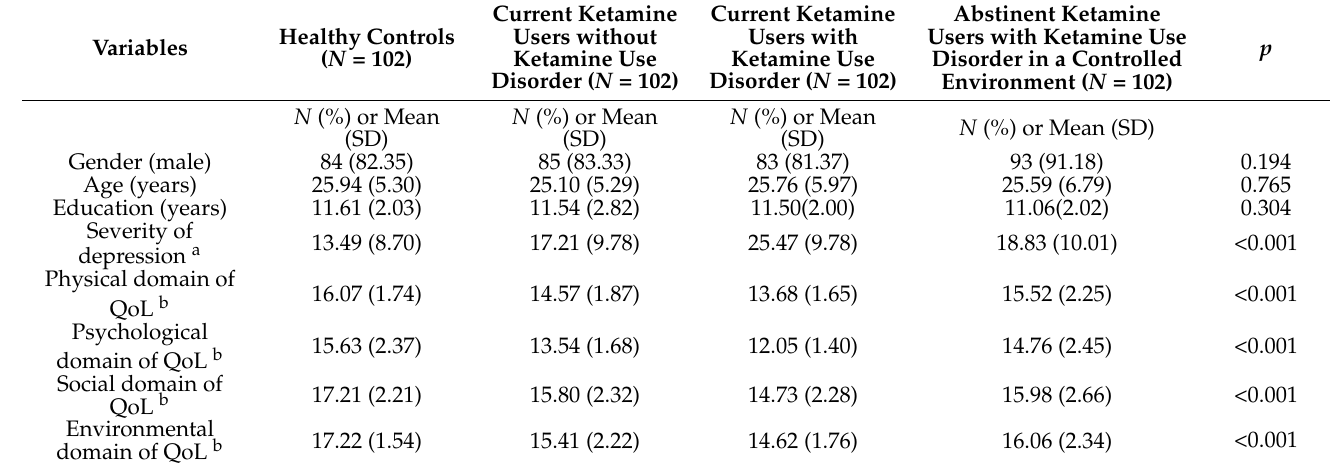
Table 1. Severity of depression and quality of life (QoL) among healthy controls and subjects with differing ketamine use status.